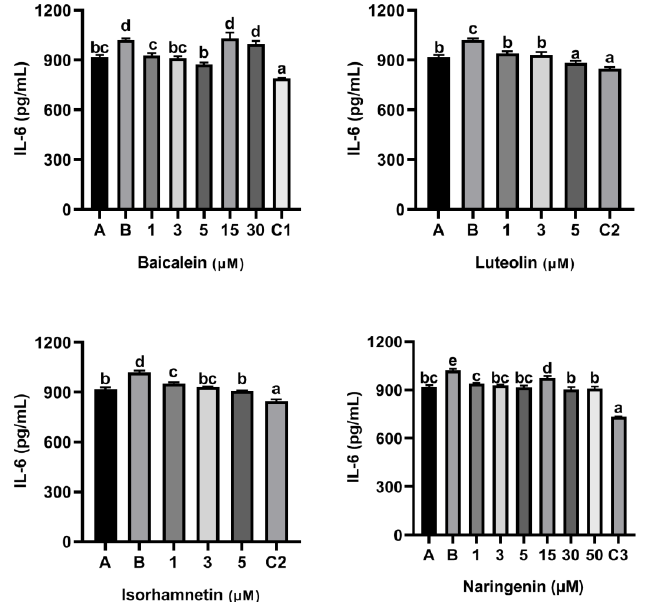
Figure 5. Effect of four flavonoids on the release of IL-6 from KU812 cells induced by ω -5 gliadin- derived peptide P4. A (blank group): only KU812 cells; B (control group): 150 µ g/mL ω -5 gliadin- derived peptide P4+KU812 cells; C1 (positive control group): 30 µ M ketotifen fumarate + KU812 cells; C2 (positive control group): 5 µ M ketotifen fumarate + KU812 cells; C3 (positive control group): 50 µ M ketotifen fumarate + KU812 cells. Note: different letters indicate significant differences between groups ( p < 0.05).